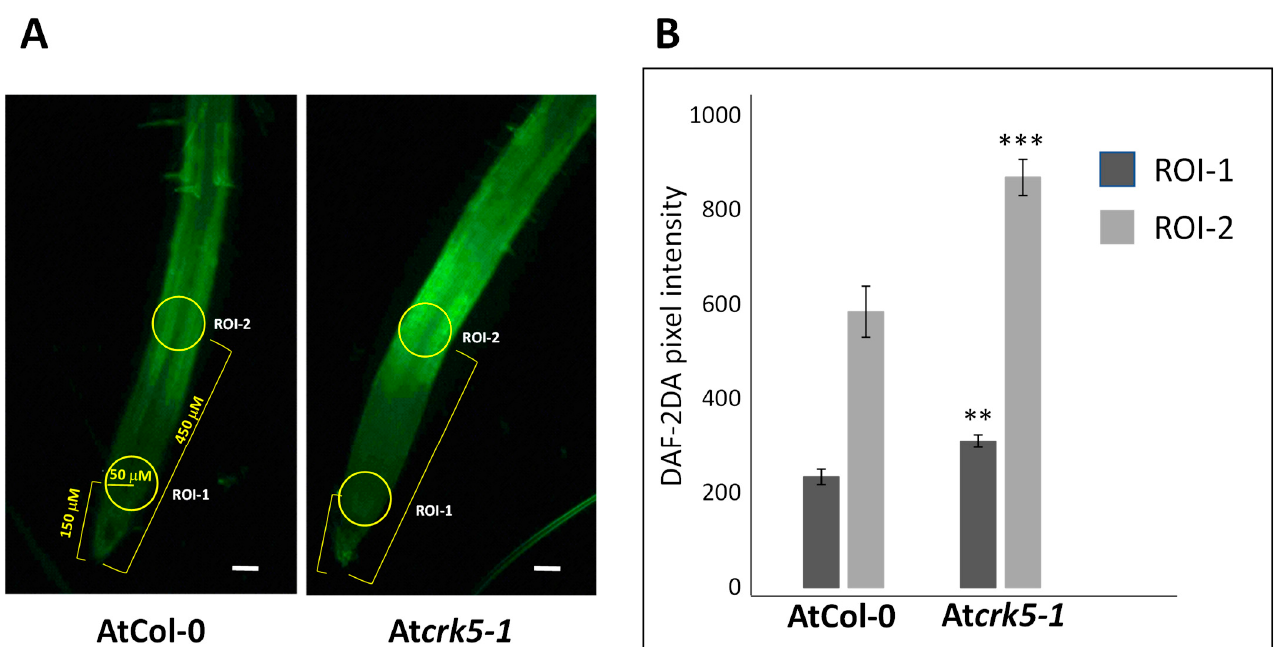
Figure 7. Detection of NO in wild type and mutant Arabidopsis root apexes. ( A ) Evaluation of NO content by the fluorescence probe DAF-FM-DA (4-amino-5-methylamino-2 ′ ,7 ′ -difluorofluorescein diacetate) in wild type (AtCol-0) and mutant (At crk5-1 ) root apices. Yellow circles represent the ROI-1 and ROI-2 (Region of Interest) in the studied roots. Scale bar = 50 µm. ( B ) Quantification of the DAF-FM DA-mediated fluorescence signal in wild type and mutant Arabidopsis root apices. DAF-FM fluorescence was measured at two identical circular regions 150 µm (dark grey, ROI-1) and 450 µm (light grey, ROI-2) away from the root tips as shown in ( A ) by yellow circles. Means (±SE) were analysed from three biological repeats ( n ≥ 25). p -values were calculated with two-tailed Student’s t-test, ** p ≤ 0.01, *** p ≤ 0.001.